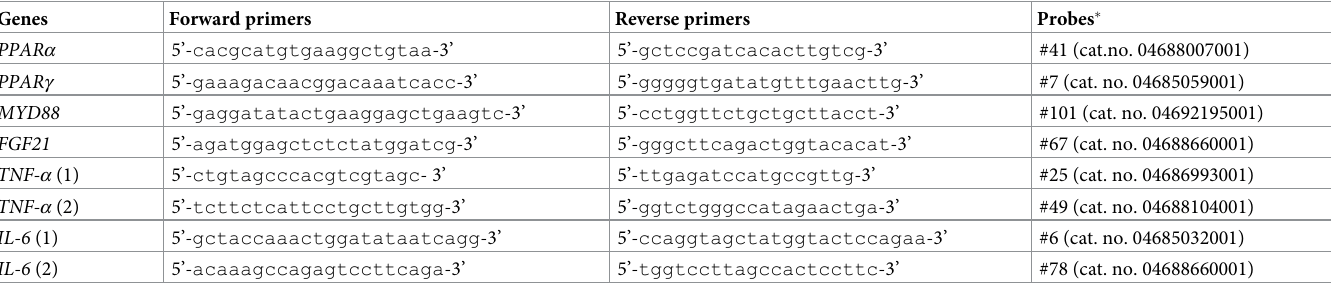
Table 1. Primer sequences and probes used for real-time reverse transcription polymerase chain reaction.